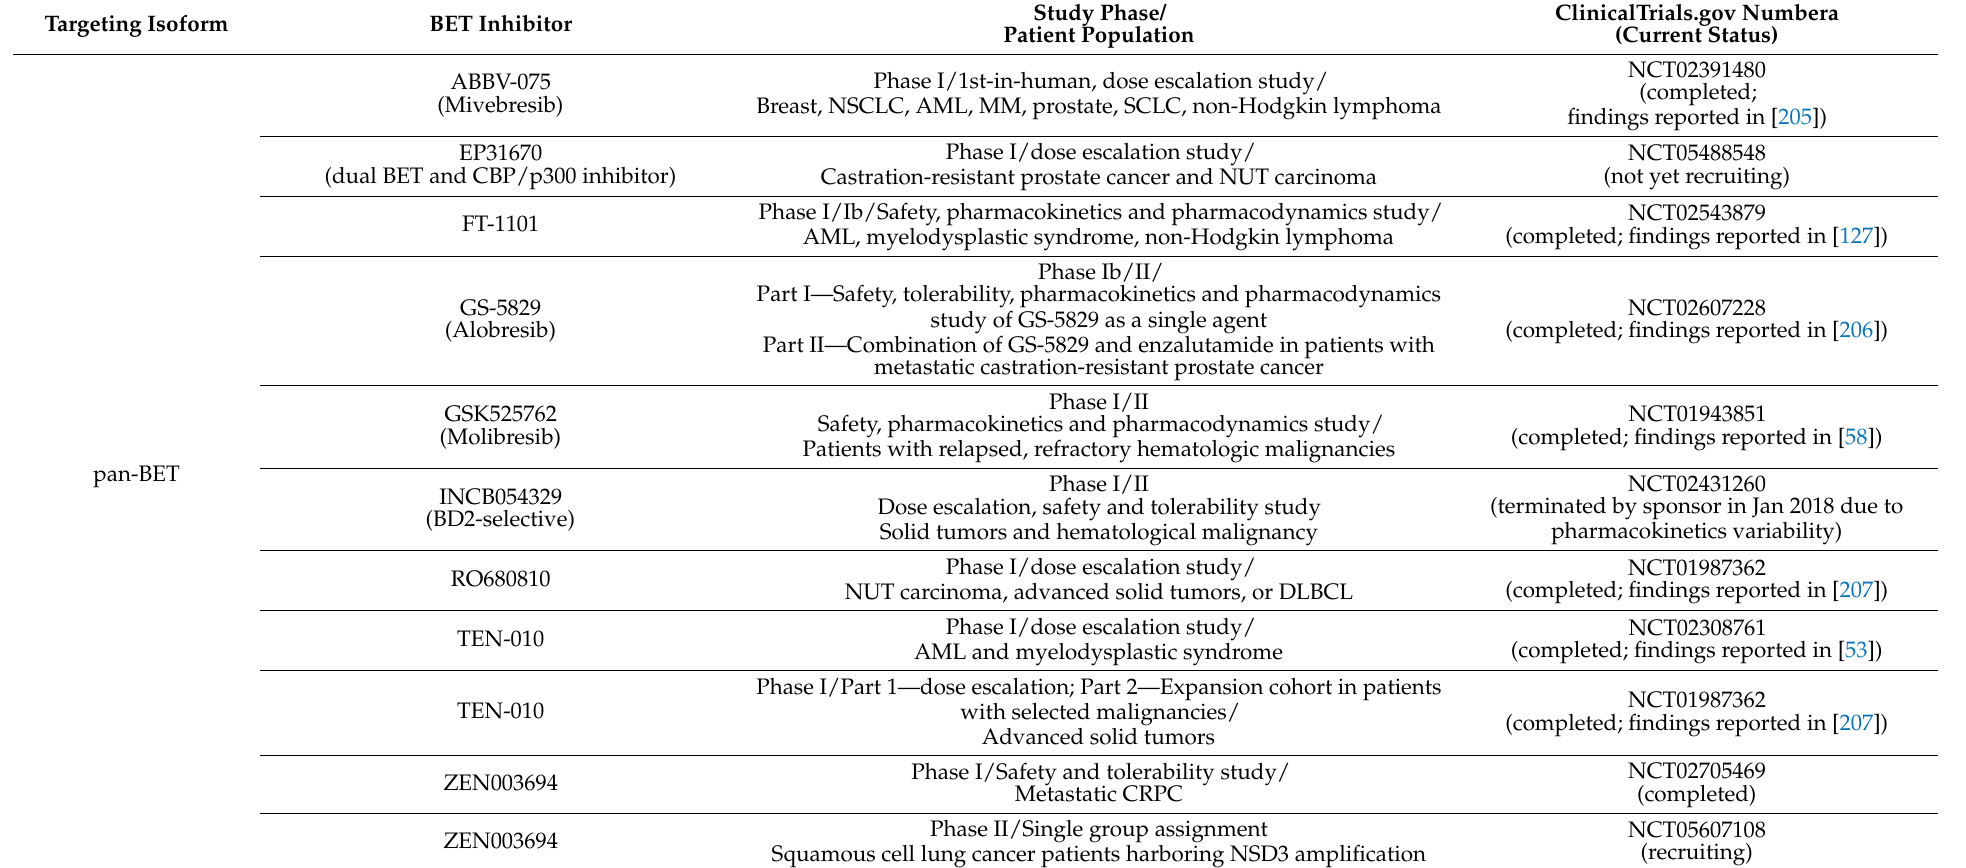
Table 2. Representative clinical trials investigating novel BET inhibitors for treatment of hematological and solid tumors in recent